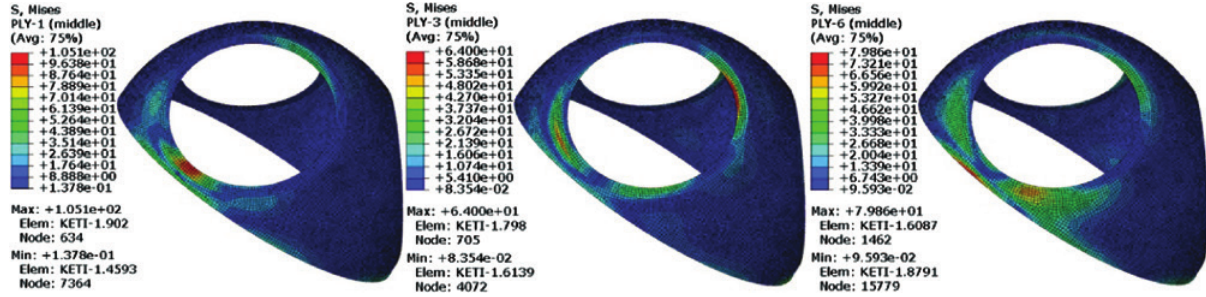
Figure 3: Stress nephogram of spherical shell’s first, third, and sixth layers (tensile